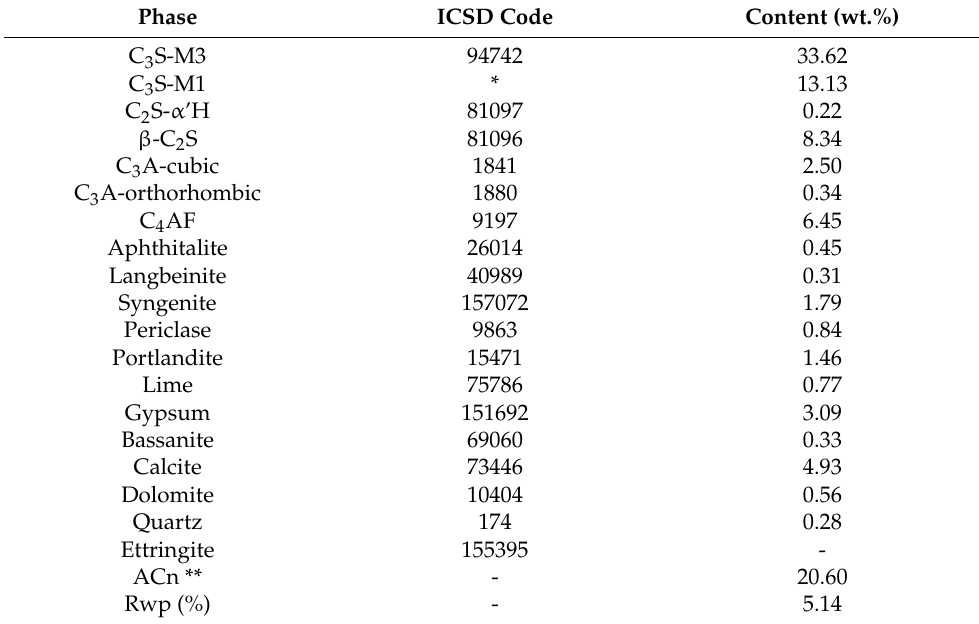
Table A1. Mineralogical composition of the cement used, obtained by XRD-Rietveld